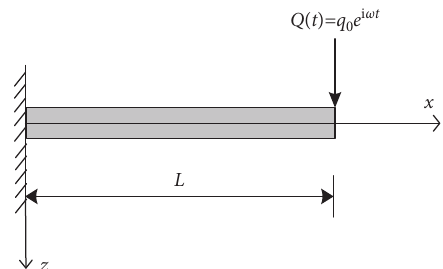
Figure 2: Incompressible nonlocal saturated poroelastic cantilever beam under vertical harmonic concentrated loading.